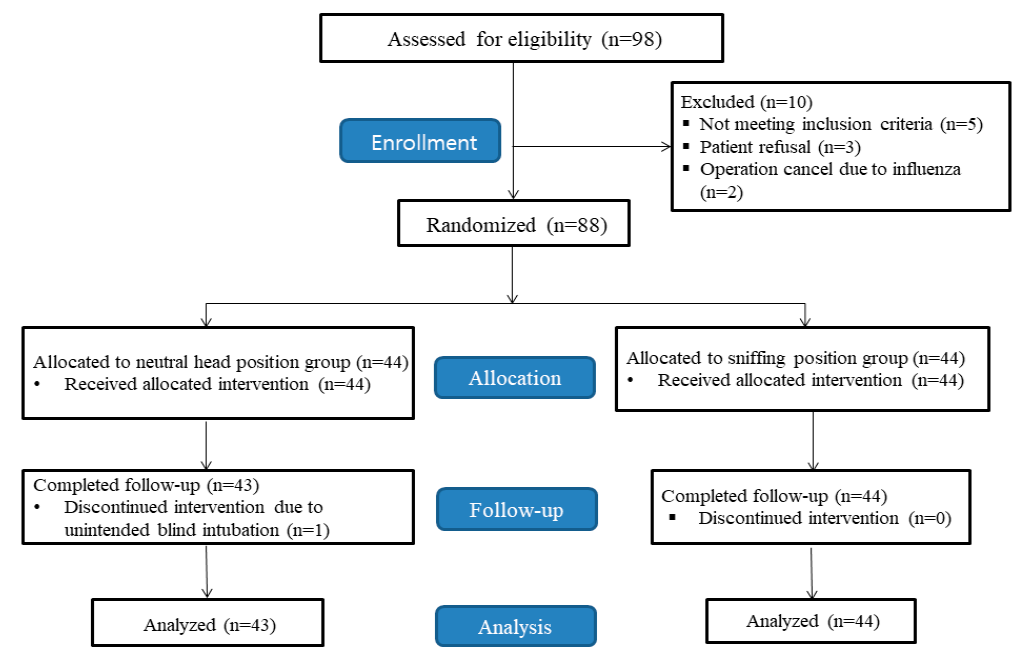
Figure 3. Consolidated Standards of Reporting Trials (CONSORT) diagram. Table 1. Baseline characteristics and preoperative airway assessment.